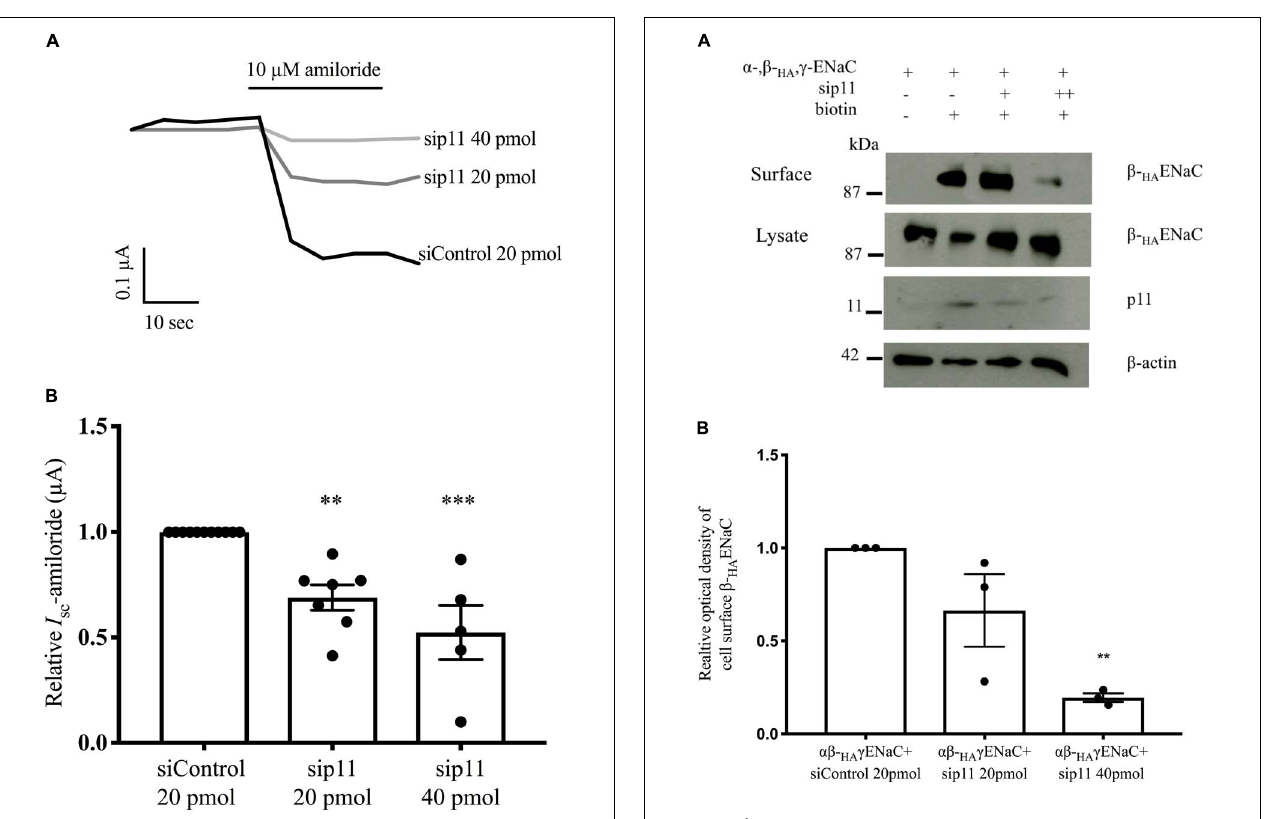
FIGURE 6 | Knockdown of p11 reduces ENaC current. FRT epithelia were grown on SnapwellTM filters, and co-transfected with plasmids encoding α -, β -, and γ ENaC (0.067 µ g each) together with either 20 pmol of control siRNA or p11 siRNA. Amiloride-sensitive short-circuit current ( I sc -amiloride) was measured 72 h after transfection. (A) Representative traces of I sc -amiloride for control and p11 knockdown epithelia. (B) Pooled results of I sc -amiloride for control and p11 knockdown epithelia, where ∗∗ indicates a significant difference to control at a level of p < 0.01 or ∗∗∗ p < 0.001 by one sample t -test, n = 5–7.